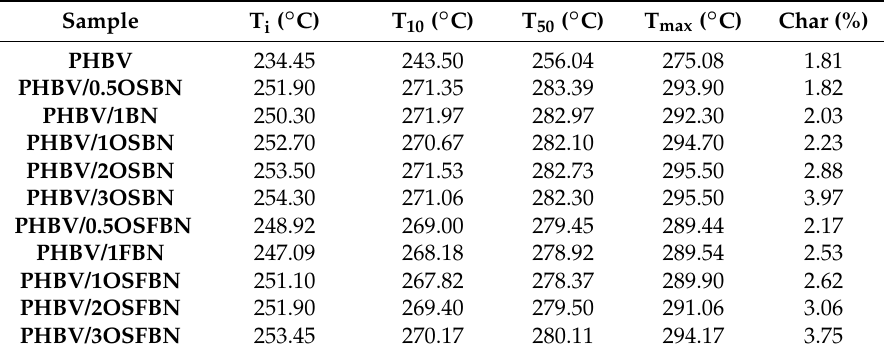
Figure 7. TG thermograms of ( a ) PHBV/OSBN and ( b ) PHBV/OSFBN nanocomposites. Table 3. TG results of nanocomposites.